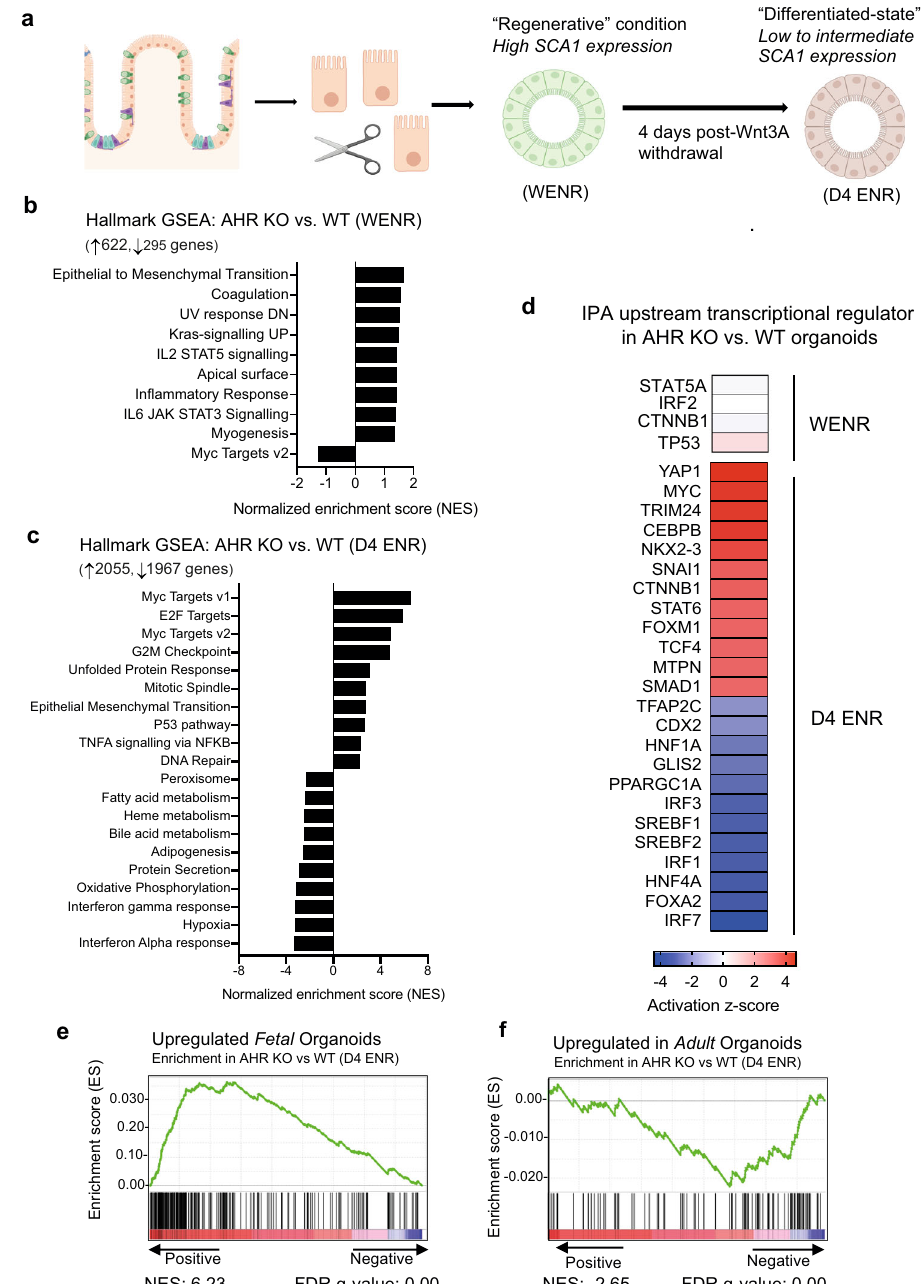
Fig. 2 Altered transcriptional program in d4 ENR AHR KO organoids. a Schematic for RNA-seq of organoids in WENR/Regenerative or d4 ENR/ differentiating conditions (created in BioRender). Normalized enrichment scores (NES) from GSEA; MsigDB Hallmark datasets of genes signi fi cantly upregulated or downregulated (FDR < 0.05) in AHR KO vs WT colon organoids grown in ( b ) regenerative (WENR) and ( c ) differentiating conditions (d4 ENR). d Heatmap for activation z-score of known transcriptional regulators predicted to be upstream of differentially expressed genes in either WENR or d4 ENR AHR KO vs WT organoids (full list in the source data; predicted factors with a p value of <0.0001 are shown). e Enrichment plot for transcriptional signature of d4 ENR AHR KO organoids compared to gene set upregulated in ( e ) fetal spheroids (NES: 6.23, FDR q value: 0.00) and ( f ) adult organoids (NES: -2.05, FDR q value: 0.00), respectively. Source data for (2 b – d ) are provided with this paper in the source data fi